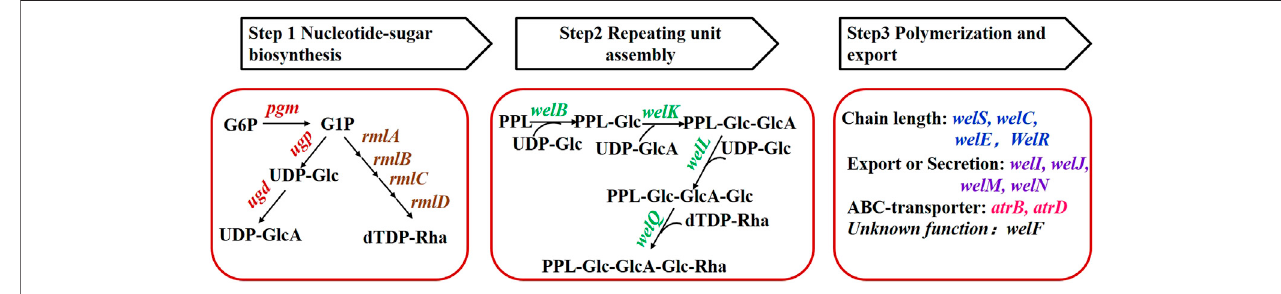
FIGURE 1 | Grouping of genes involved in WL gum biosynthesis. G6P: glucose-6-phosphate, G1P: glucose-1-phosphate, PPL: